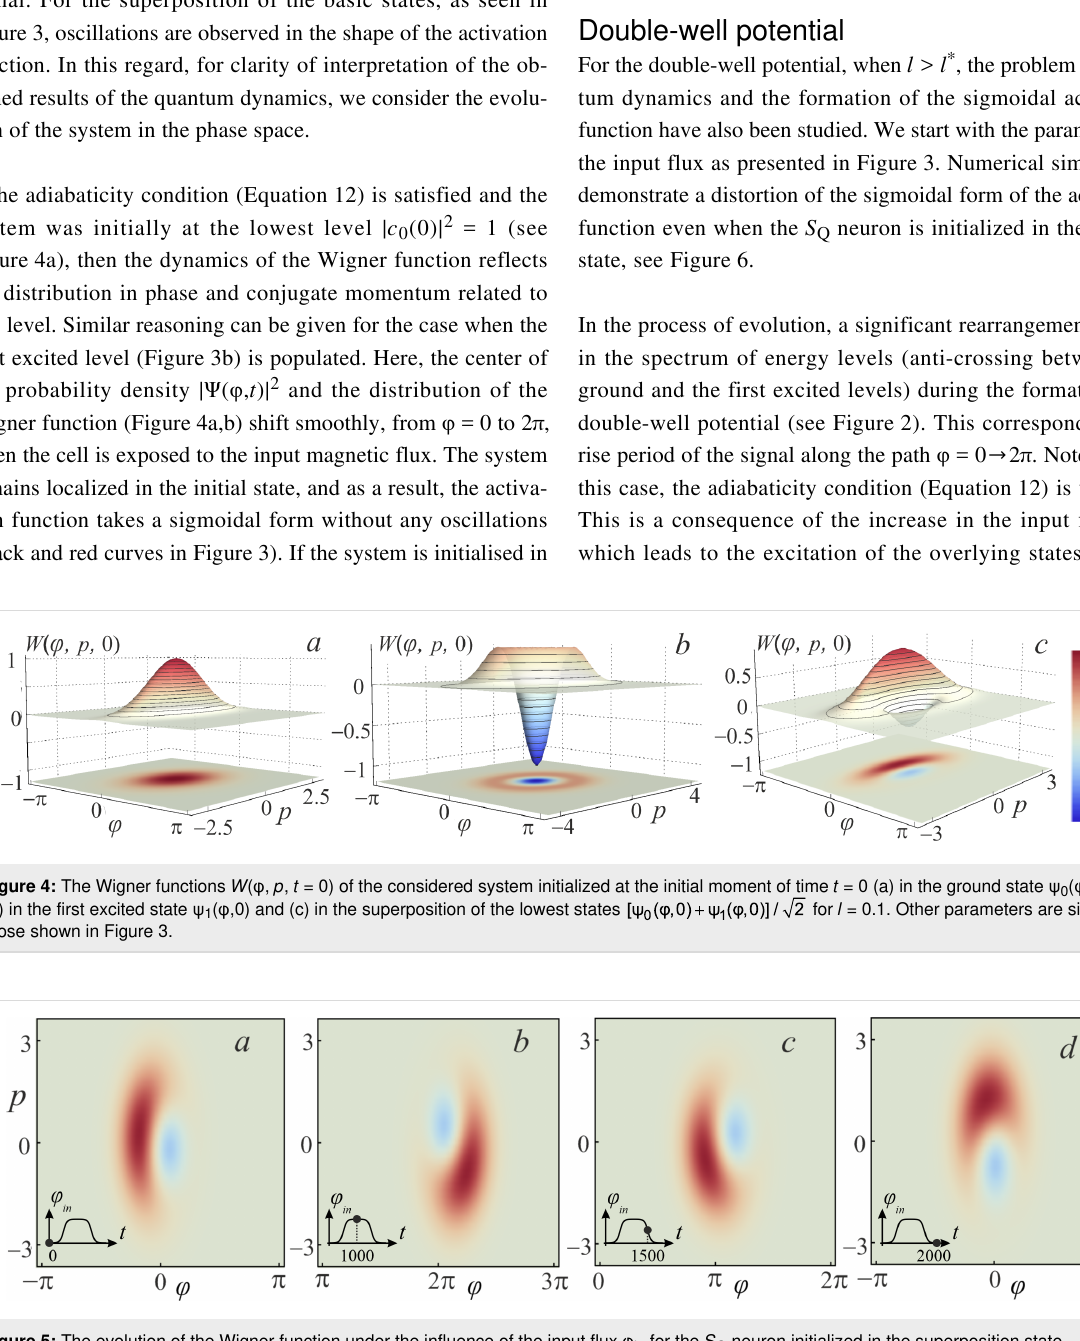
Figure 5: The evolution of the Wigner function under the influence of the input flux φ in for the S Q neuron initialized in the superposition state at the moments t = 0 (absence of φ in ) (a); t = 1000 (the plateau of φ in ) (b); t = 1500 (the middle of the decreasing branch of φ in ) (c); t = 2000 (absence of φ in ) (d). The remaining parameters are similar to those shown in Figure